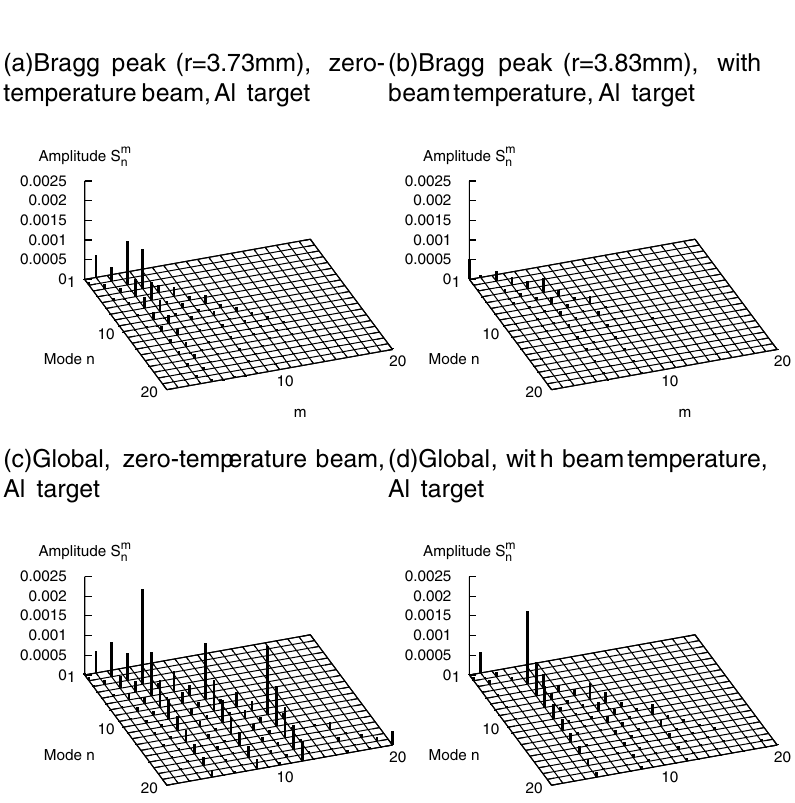
for the (c) zero- i